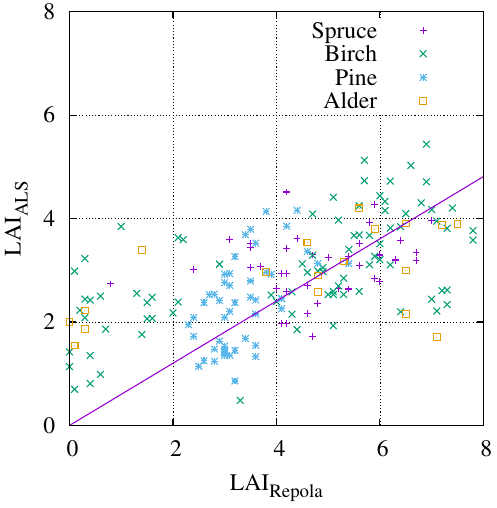
Figure 12. Allometric [35] and ALS estimates of